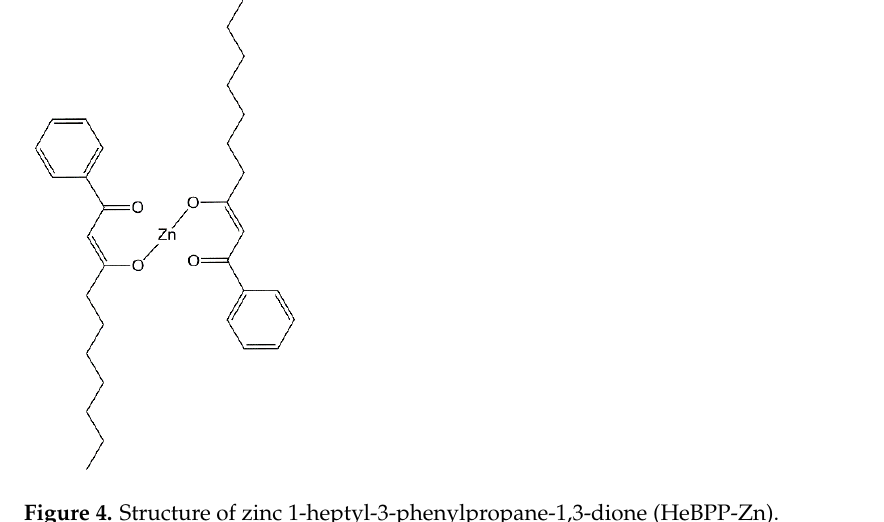
Table 1. General formulations of the styrene-butadiene-rubber (SBR) compounds, parts per hun- dred of rubber (phr); MBT, 2-mercaptobenzothizole; CBS, N-cyclohexyl-2-benzothiazolesulfena-